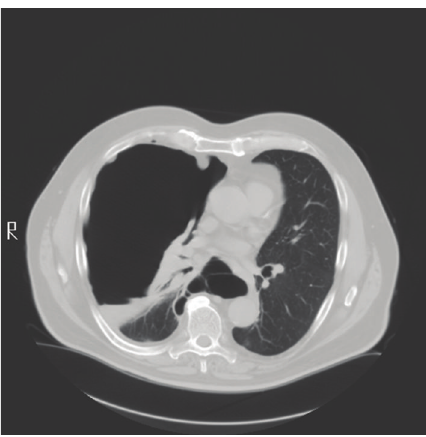
Figure 4: Chest CT scan in August 2008 showing a large right pneu- mothorax with atelectasis of the right upper and middle